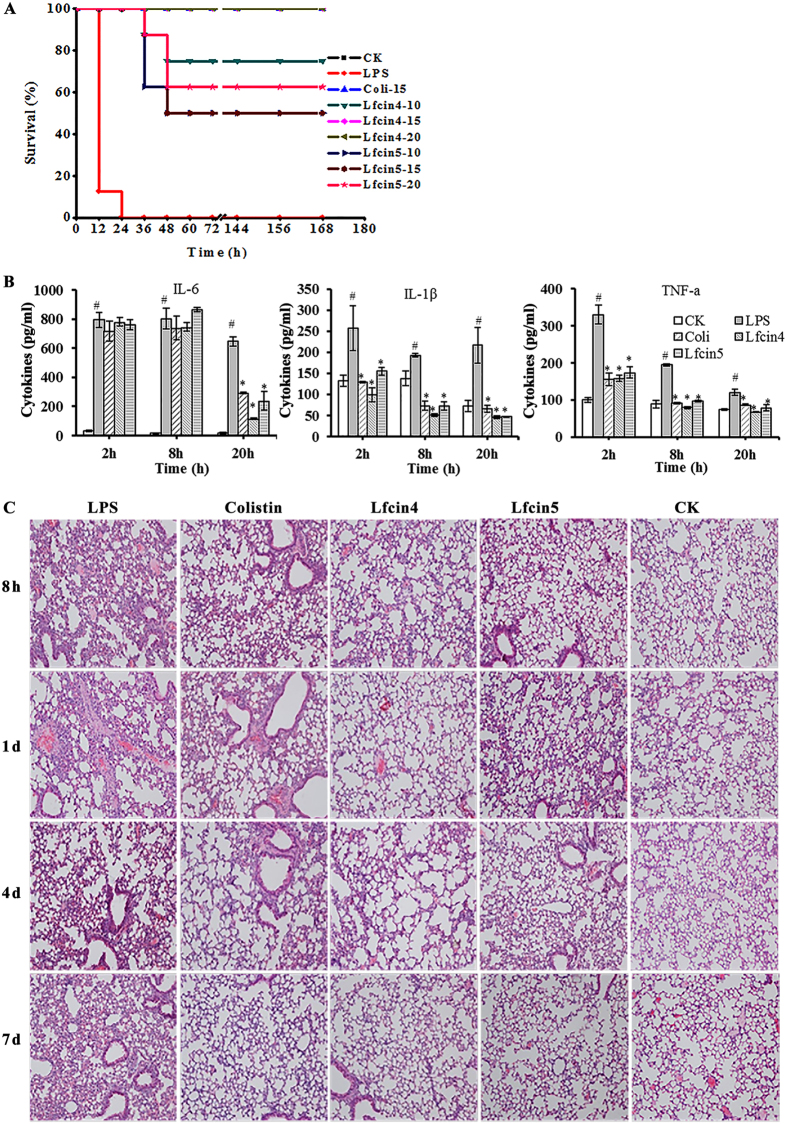
Effects of Lfcin4 and Lfcin5 on LPS-induced responses in vivo.(A) Groups of eight C57BL/6 mice were intraperitoneally injected with LPS from E. coli O111:B4 (30 mg/kg of body weight). Thirty minutes after LPS injection, Lfcin4, Lfcin5, colistin, or saline was administered intraperitoneally. Survival was recorded every 12 h and followed for up to 7 d. (B,C) C57BL/6 mice were intraperitoneally injected with 10 mg/kg LPS followed by intraperitoneal administration of 15 mg/kg Lfcin4, Lfcin5 or colistin 30 min later. Mice treated with buffer only served as a control. Cytokines were measured in blood from mice sacrificed at 2 h, 8 h or 20 h after LPS injection. The results are presented as the mean ± SEM. Differences between groups were determined by one-way ANOVA followed by SPSS analysis (n = 3 per group). #p < 0.05 compared to the control group and *p < 0.05 compared to the LPS-treated group (B). Light microscopy images (10 × magnification, scale bar: 100 μm) of lung tissue from representative mice sacrificed at 8 h, 1 d, 4 d, and 7 d after LPS injection (C).